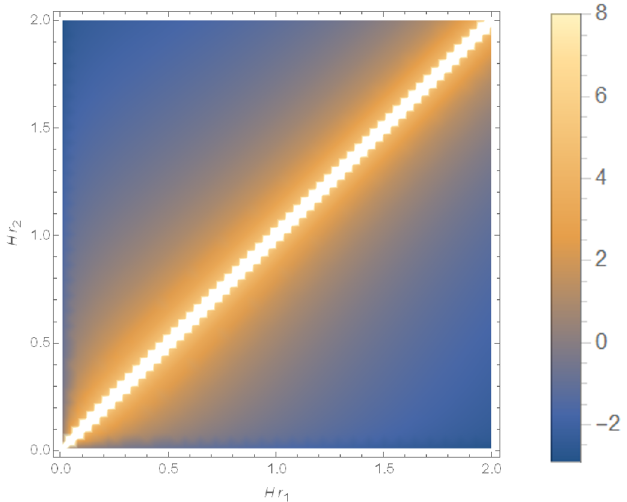
Figure 1 . Density plot of ¯ G ( r 1 , r 2 ) for Hr b = 0 . 2 . The horizontal axis is Hr 1 and the vertical axis is Hr 2